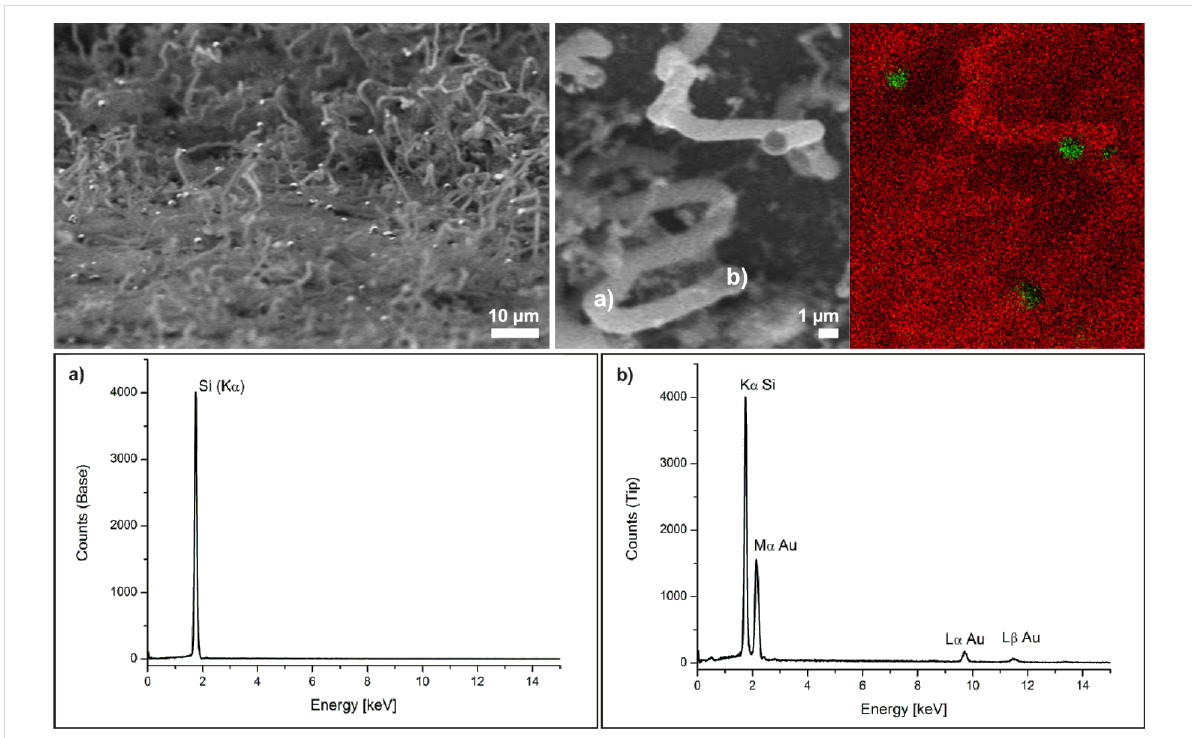
Figure 2: Analysis of NWs grown on gold-sputtered Si[111] for 1 h at 375 °C. Top left: Backscattered-electron image. The bright spots at the tips indi- cate the presence of a high- z material (gold). Top right: Composite EDX mapping image, green = gold, red = silicon. Bottom: EDX spectra obtained (a) at the base, (b) at the tip of the NWs.